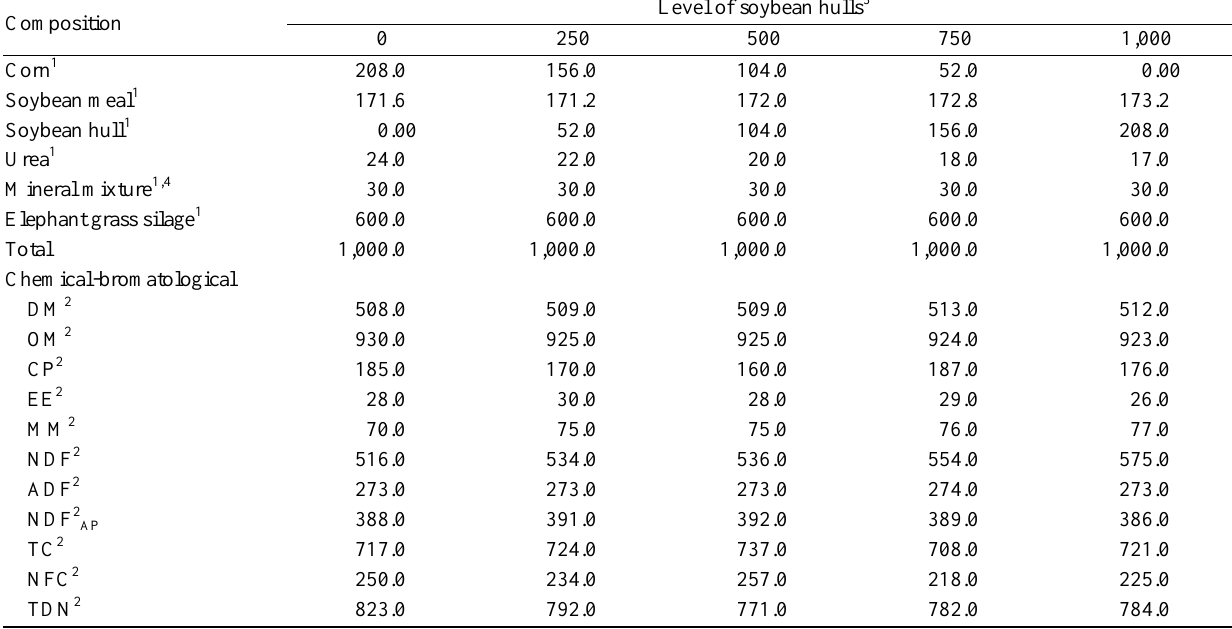
Table 2. Ingredient and chemical-bromatological (g/kg) composition of experimental diets